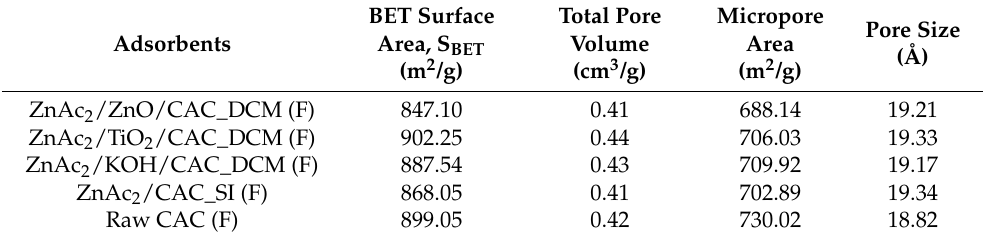
Table 2. Porous properties for fresh DCM/CAC, SI/CAC and raw CAC